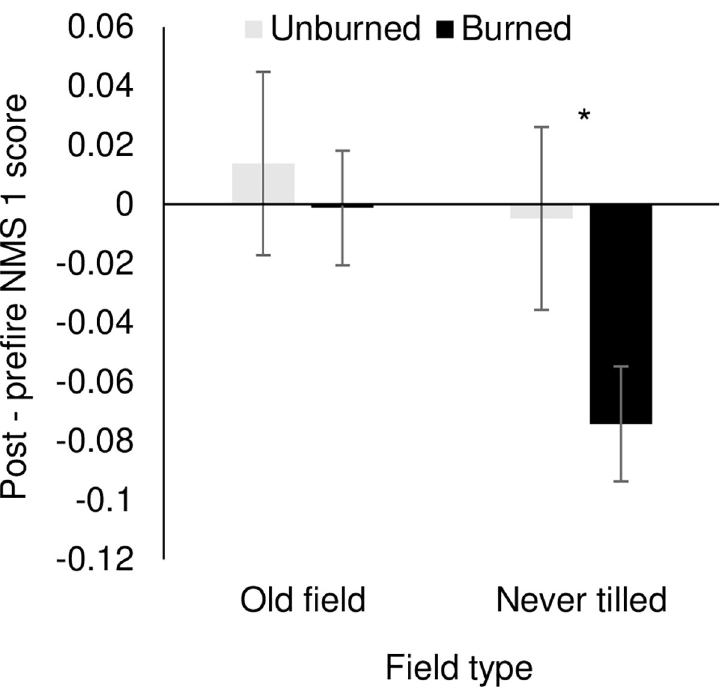
Fig 4. Change in NMS axis 1 values after a wildfire in 2014. Values calculated as the difference between 2015 scores and the average of 2002 to 2014 values. Negative post-prefire NMS scores indicate increased weediness. An asterisk indicates a difference between Unburned and Burned values at the α = 0.05